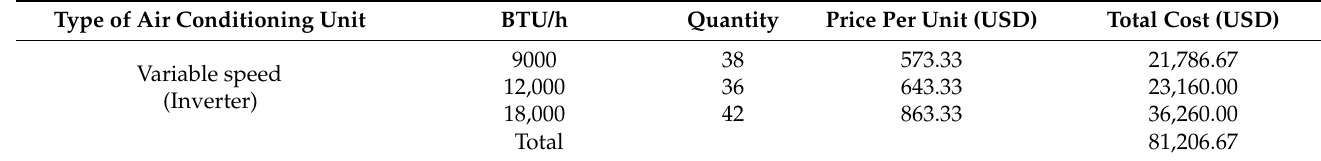
Table 19. Equipment and installation cost of air conditioning